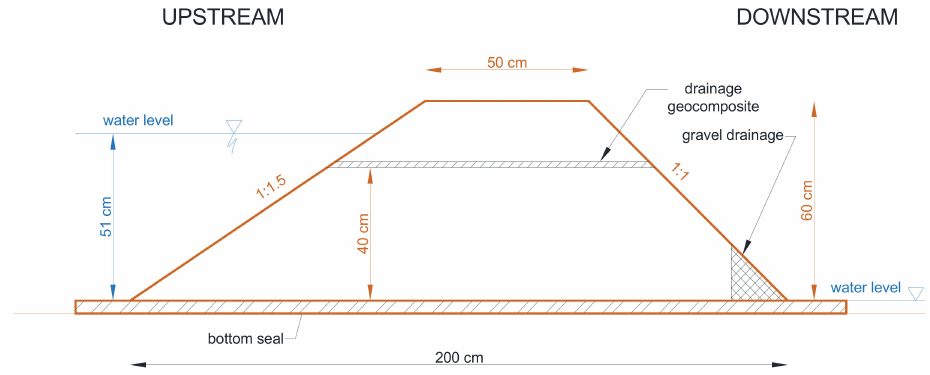
Figure 2. Cross-section of the model embankment with embedded geosynthetic.